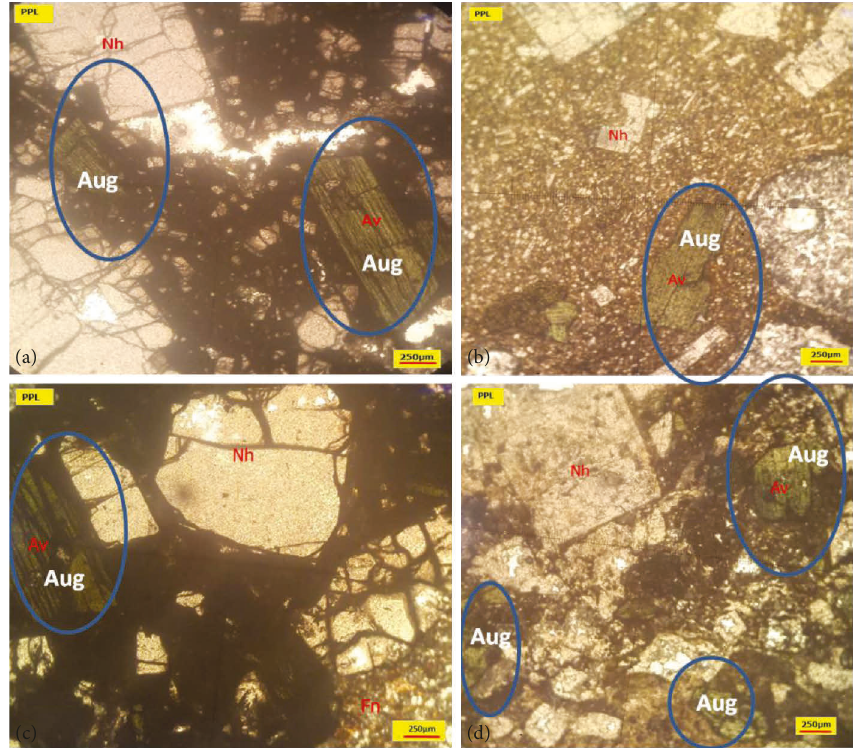
Figure 5: Petrographic microphotographs of the four rock samples taken from the foot of Oldoinyo Lengai